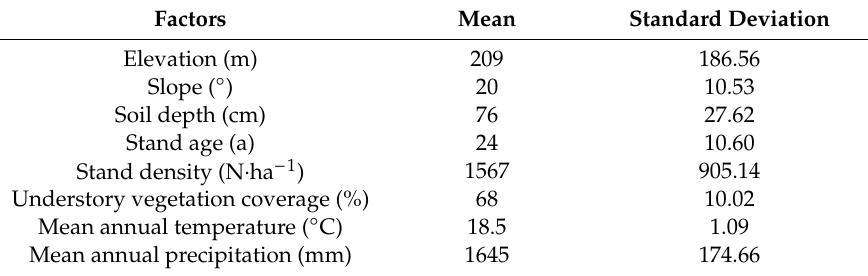
Figure 1. Location of the study area (Jiangxi Province, China) and Pinus massoniana sample plots. Table 1. Description of Pinus massoniana sample